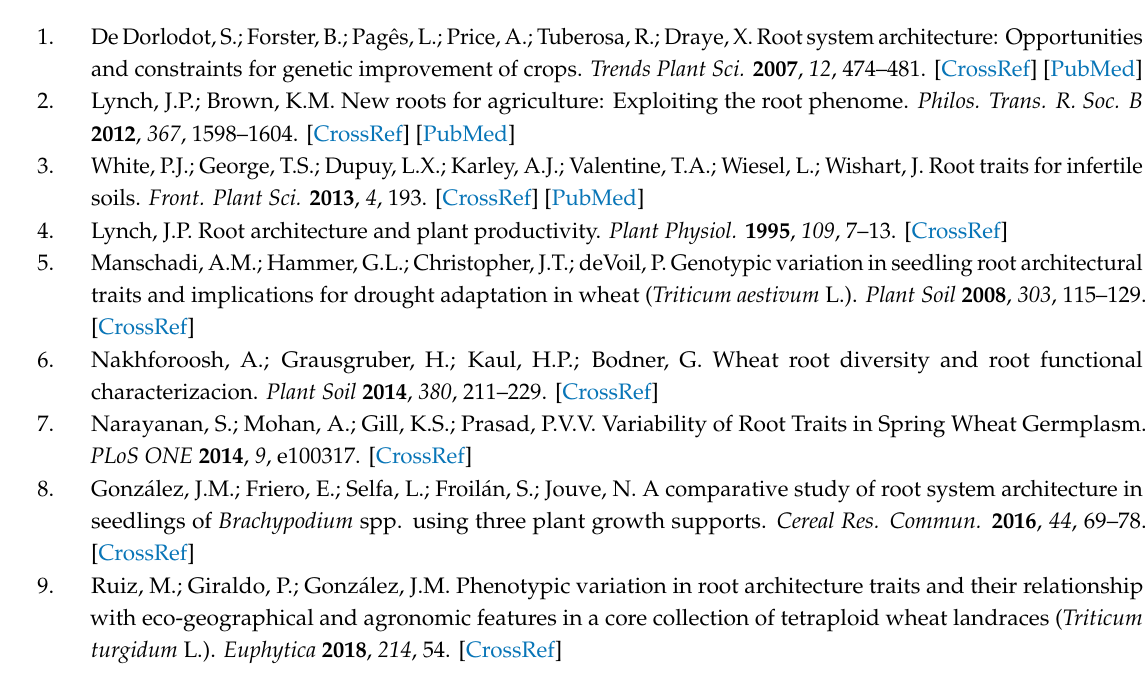
Table S1: Matrix of presence / absence of 117 SSRs analysed in the twelve genotypes of the three Brachypodium